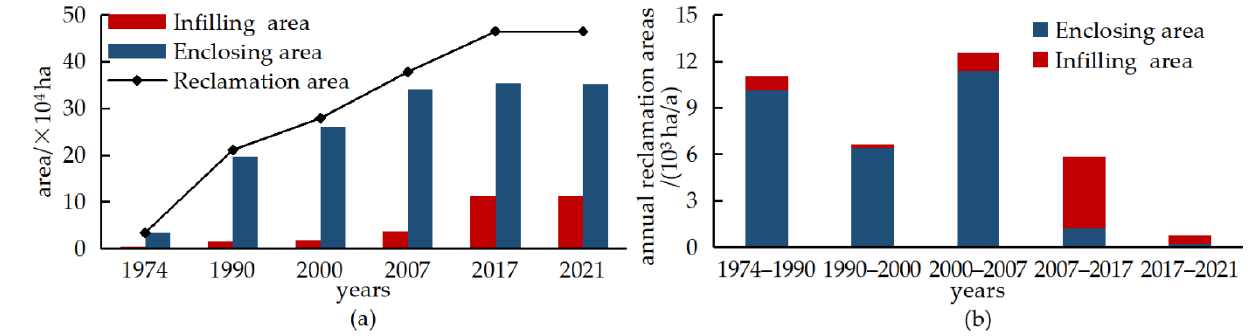
Figure 3. Reclamation area ( a ) and its average annual increase in the study area from 1974 to 2021 ( b